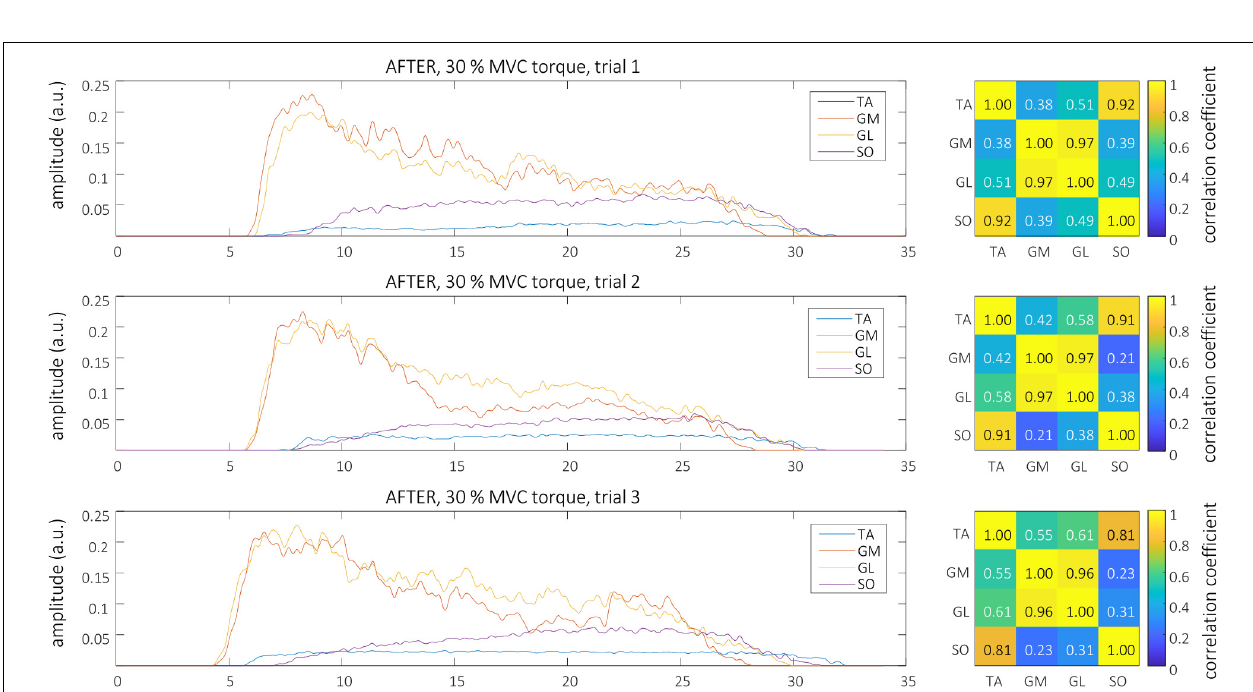
FIGURE 1 | Left, CSTs as calculated from the tibialis anterior (TA), gastrocnemius medialis (GM), gastrocnemius lateralis (GL), and soleus (SO) muscles of older participant (O1) during the three trials at 30% MVC torque before the bed rest. Right, The muscle coactivation as revealed by the cross-correlation analysis of CSTs of different muscles.